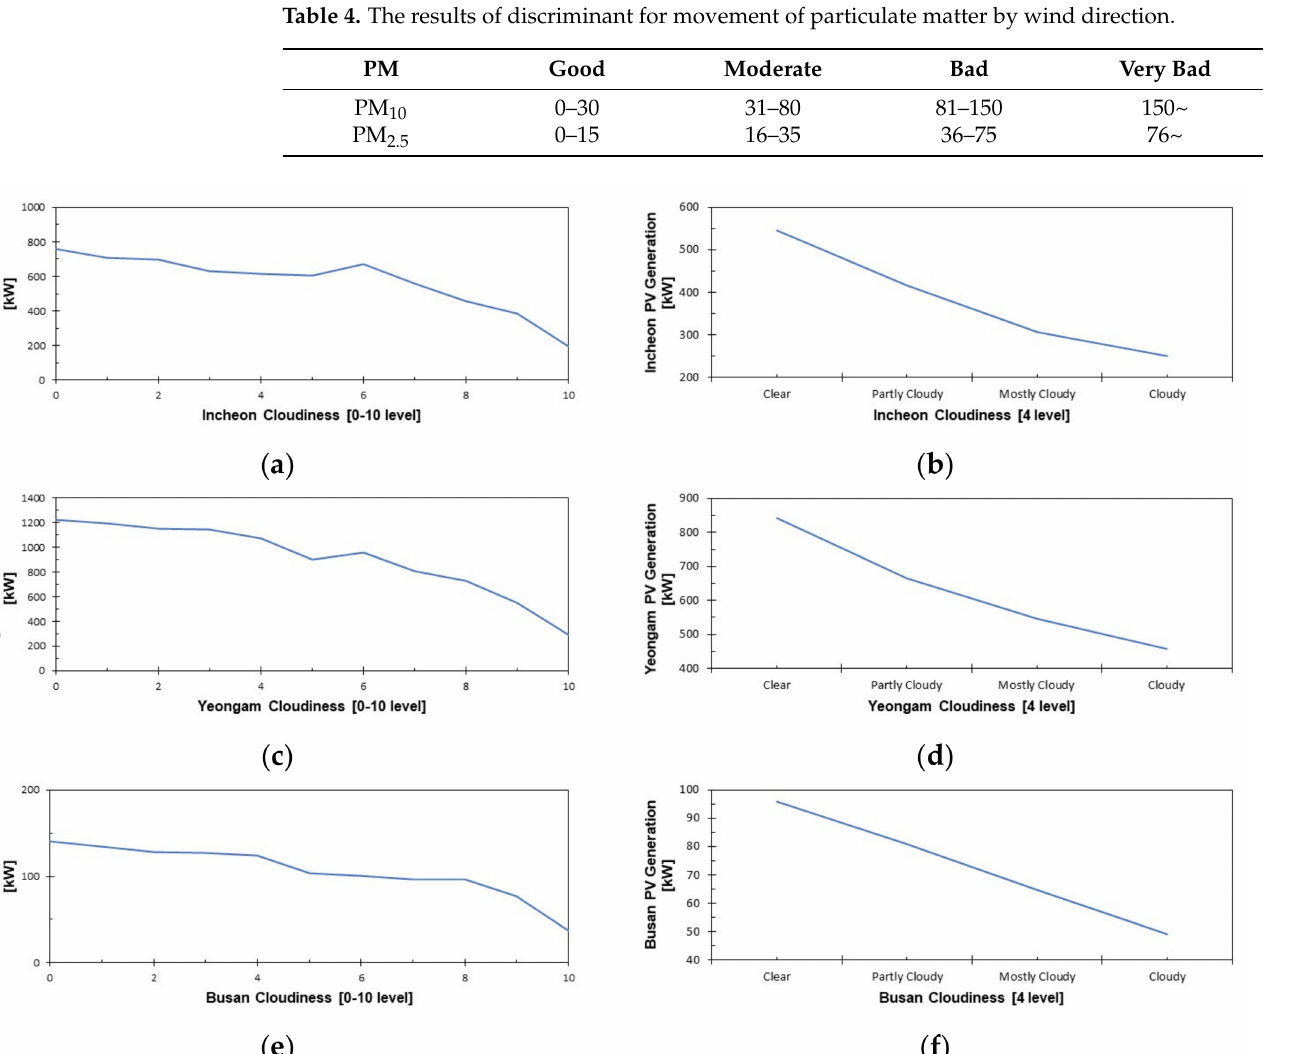
Figure 5. The reduction rates of solar PV generation according to cloudiness: ( a ) The reduction rates in Incheon (KMA); ( b ) The reduction rates in Incheon (NMSC); ( c ) The reduction rates in Yeongam (KMA); ( d ) The reduction rates in Yeongam (NMSC); ( e ) The reduction rates in Busan (KMA); ( f ) The reduction rates in Busan